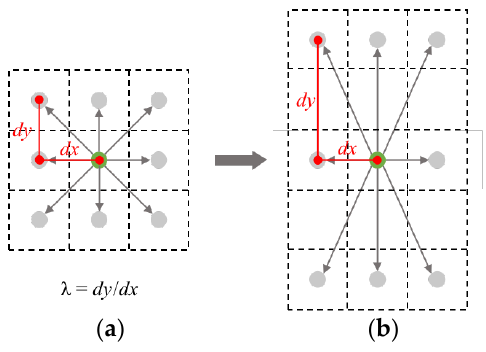
Figure 2. The base-offset of deformable convolution kernel (calculated by 𝜆 = 𝑑𝑦 𝑑𝑥⁄ ). ( a ) stand- ard base-offset 𝜆 = 1 ; ( b ) base-offset initialization with 𝜆 > 1 . base-offset λ = 1; ( b ) base-offset initialization with λ >